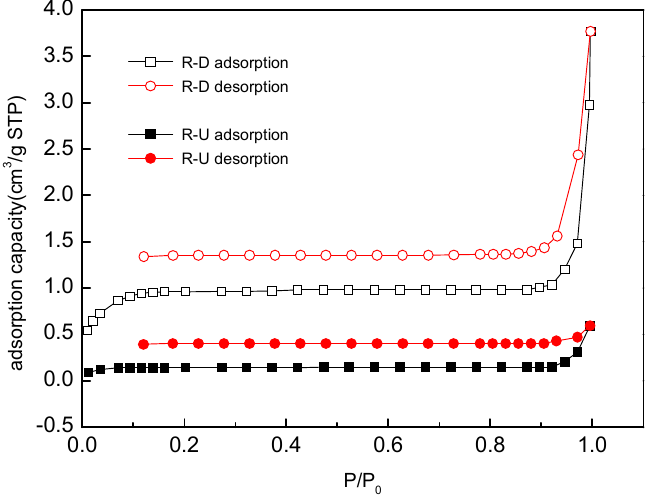
Figure 6. Adsorption–desorption isotherm [33].